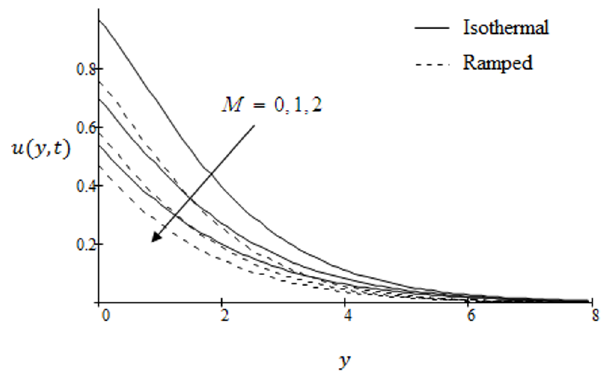
Figure 5. Velocity profiles for different values of M when the plate applies a constant shear stress f ~{ 0 : 25 .